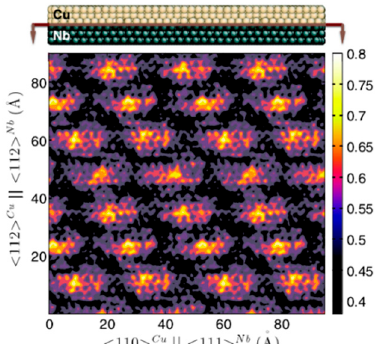
Figure 15. Location dependence of Cu/Nb interface energy. Areas occupied by MDIs deliver the highest interface energy. Reprinted with permission from [96]; Copyright 2013 NLM.